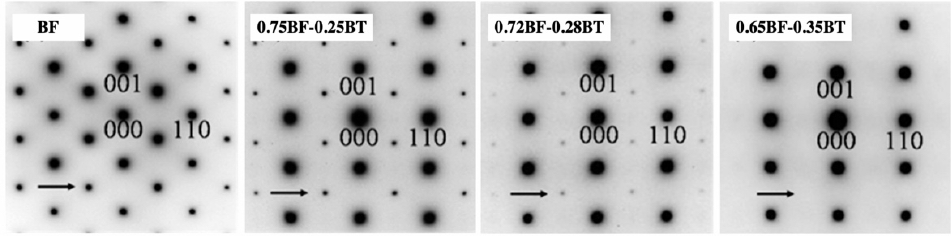
Figure 8. Electron diffraction patterns at room temperature with [1 1 0] incidence in BF–BT ceramics. Reprinted with the permission of [76]. Copyright © 2008 Taylor and Francis.